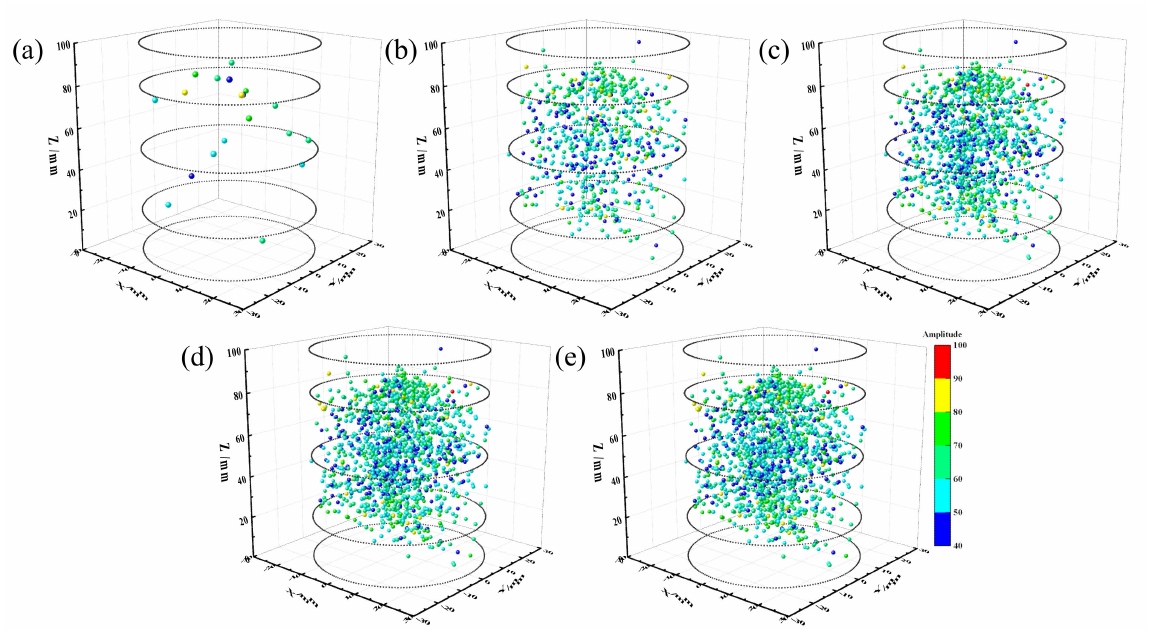
Figure 11. Spatial evolution of AE events of coal samples under different loading rates (3.0 mm/min): ( a ) crack compaction phase, ( b ) crack initiation phase, ( c ) stable crack growth phase, ( d ) unstable crack growth phase, and ( e ) post-peak failure phase.